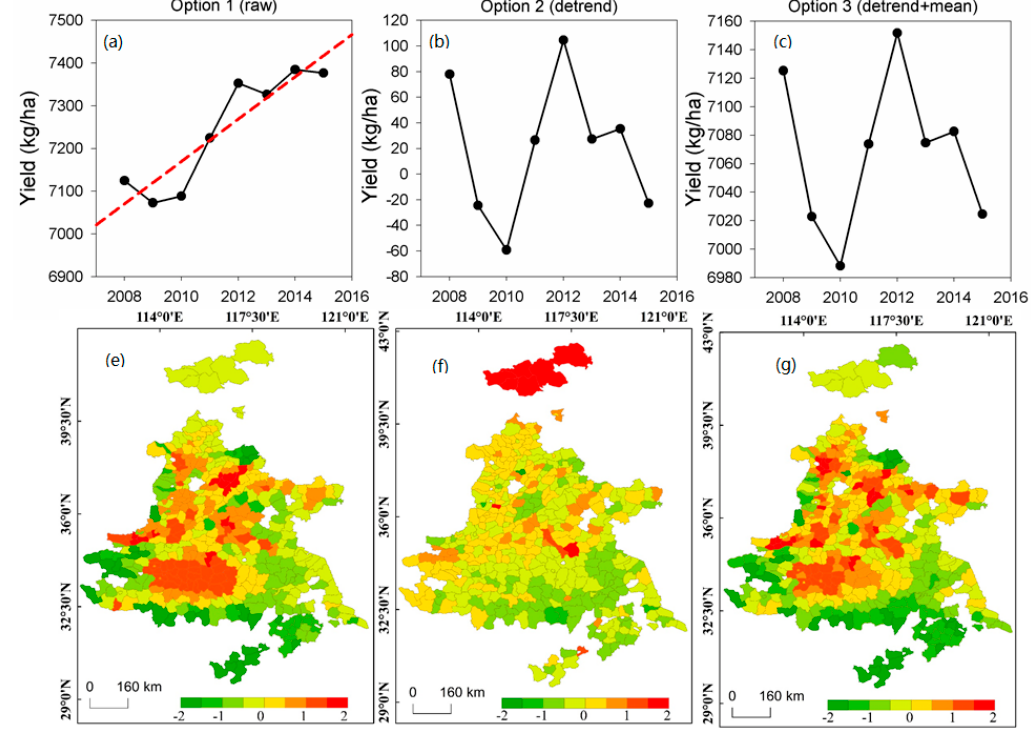
Figure 2. A typical example to illustrate the differences in spatial and temporal patterns of data from Options 1–3. Option 1 uses raw county-level data (the red dashed line shows its linear fit) ( a ); Option 2 removes the linear trend (the red line in Option 1) from the raw data ( b ), and Option 3 adds the multi-year average of the raw county-level data into the Option 2 data ( c ); ( e )–( g ) express the spatial patterns of the three types of yields corresponding to each Option.